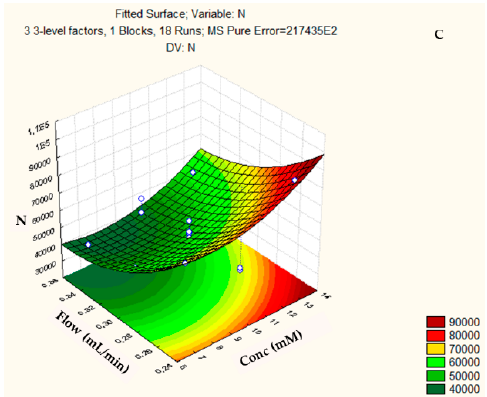
Figure 5. Three-dimensional response surface plot showing the effects of the mutual interactions between two independent variables ( a ) Flow and Temperature; ( b ) Concentration and Temperature; and, ( c ) Flow and Concentration on column efficiency (N) of the chromatographic analysis on the ZIC-p-HILIC column.